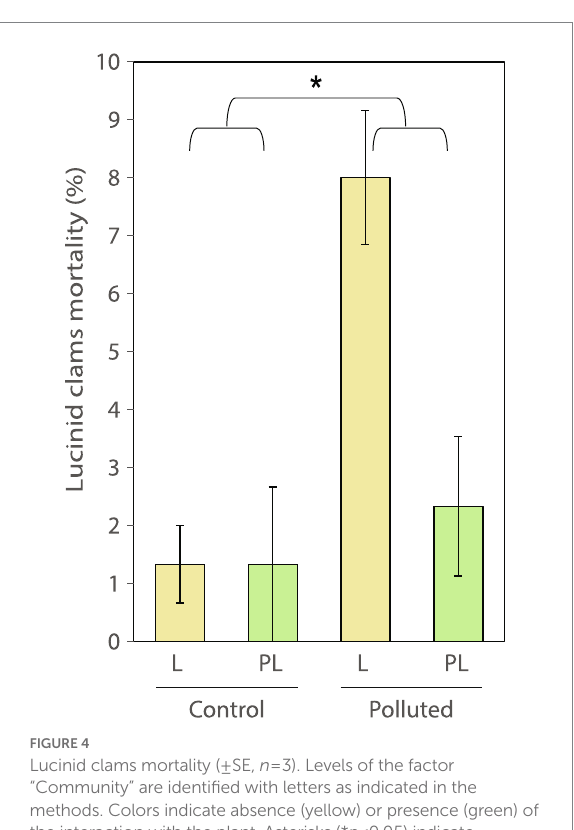
FIGURE 4 Lucinid clams mortality (±SE, n = 3). Levels of the factor “Community” are identified with letters as indicated in the methods. Colors indicate absence (yellow) or presence (green) of the interaction with the plant. Asterisks (* p < 0.05) indicate significant differences; see Supplementary Table S6 for the